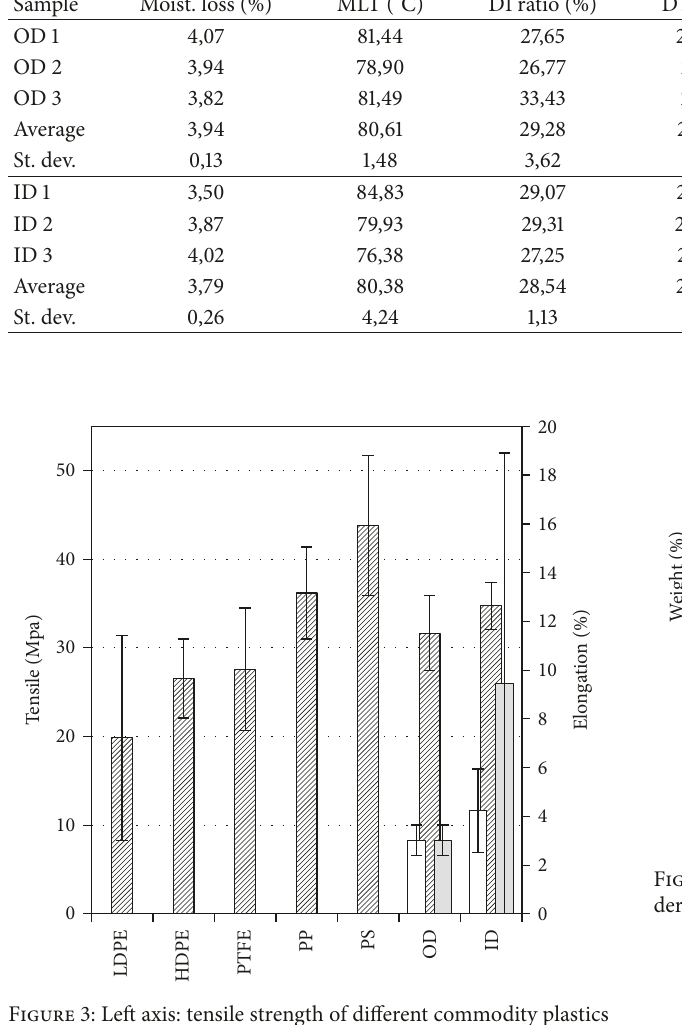
Figure 3: Left axis: tensile strength of different commodity plastics [16] and tensile strength at maximum load of OD and ID films are shown; right axis: elongation at maximum tensile strength (white bars) and elongation at break (grey bars) belonging to OD and ID films are shown (elongation at break of commodity plastics is not shown in the image due to the great difference of values).